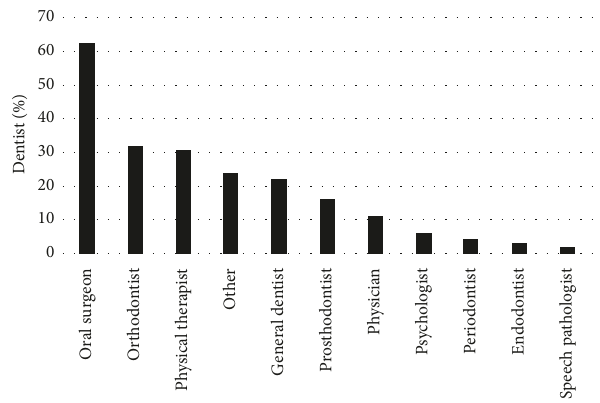
Figure 1: Health care providers TMD patients are referred